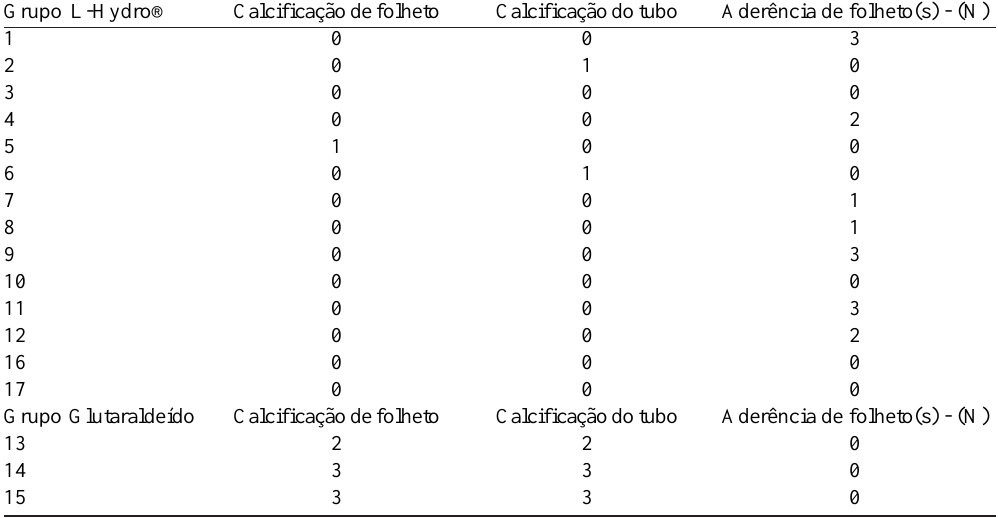
Tabela 3. Mensuração de calcificação: 0- ausência de calcificação; 1- calcificação leve; 2- calcificação moderada; 3- calcificação importante. Avaliação de aderência de folhetos.